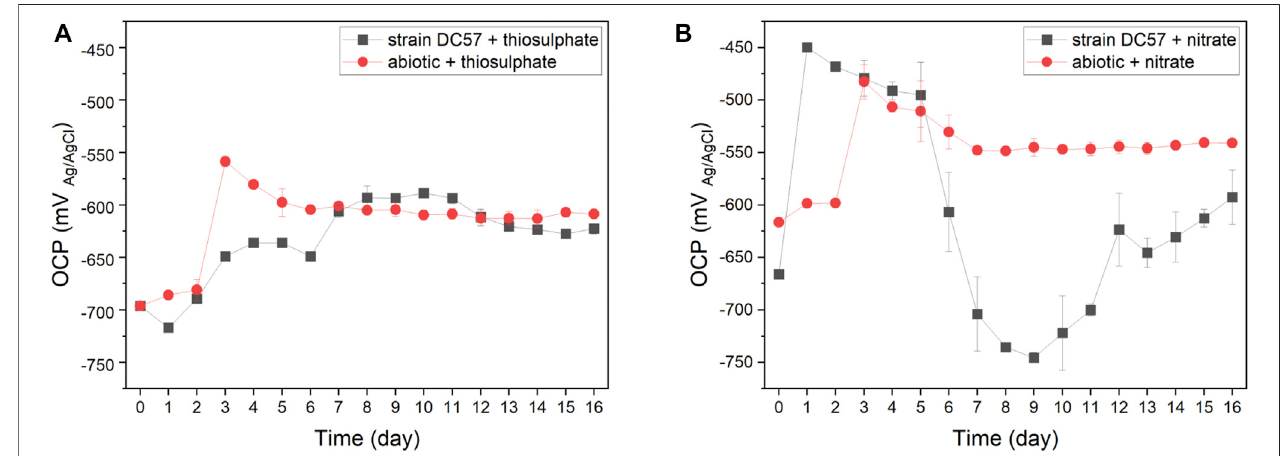
FIGURE 1 | Variation of OCP vs. time during 16-days exposure to thiosulphate (A) and nitrate (B) reducing conditions.